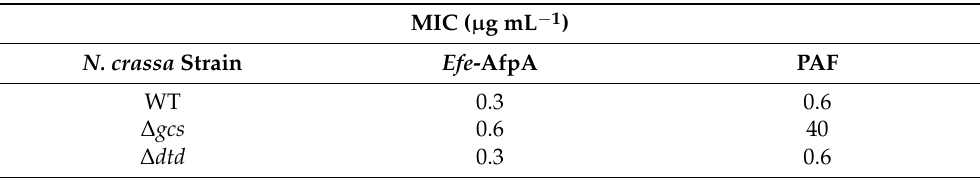
Figure 11. Efe -AfpA ( A ) and PAF ( B ) activity against N. crassa wild type and glucosylceramide pathway mutants. Increasing concentrations of the proteins were assayed for activity in the N. crassa growth assay with 1 × 10 4 conidia mL − 1 . The data presented are the means and standard deviations of three replicates. For each concentration, columns with different letters indicate a significant difference in activity ( p ≤ 0.05, two-way ANOVA). Table 3. Minimum inhibitory concentrations of Efe -AfpA and PAF against wild type and glucosylce- ramide mutant strains of Neurospora crassa